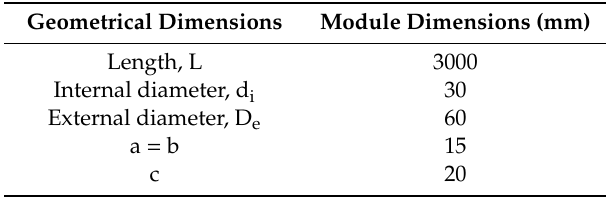
Table 1. Geometrical dimensions of the separation module.